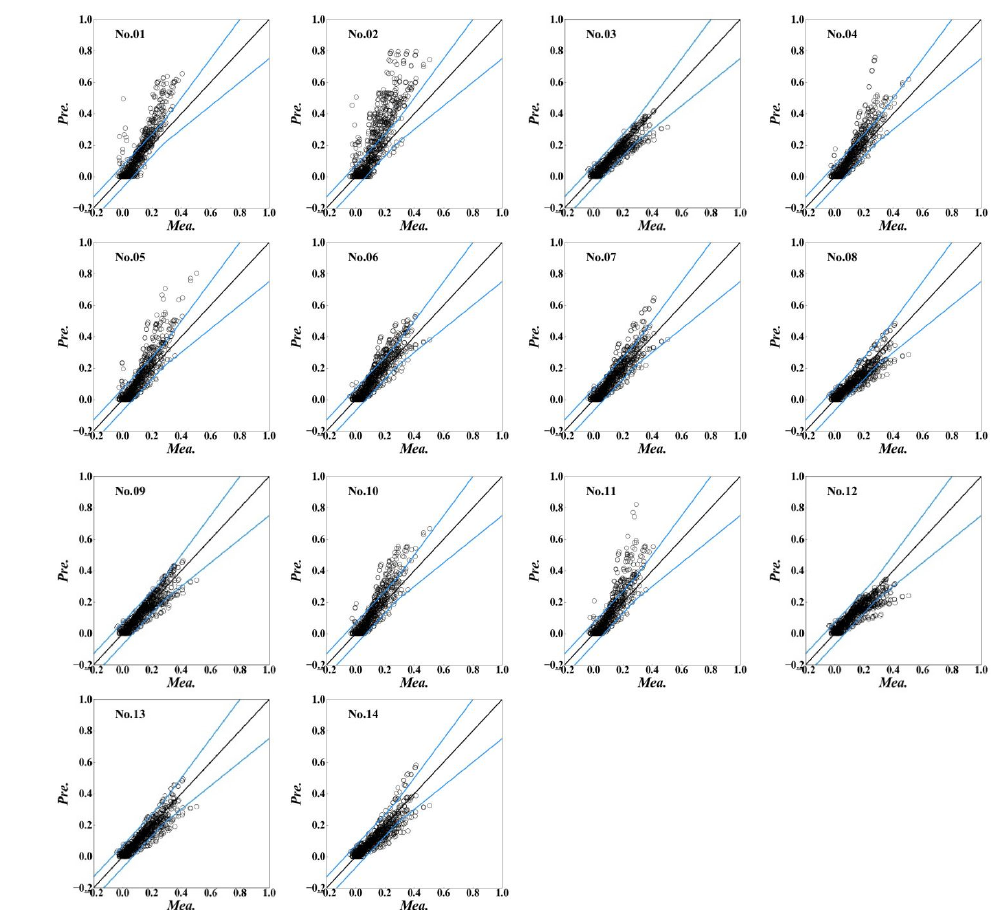
Figure A1. Comparisons of the combined wake models with the cosine ‐ shaped distribution.